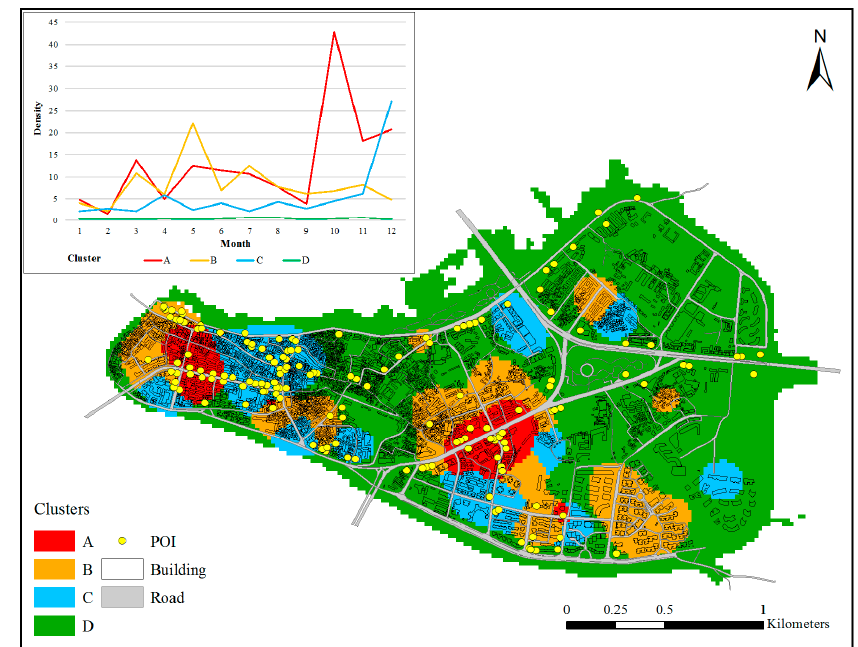
Figure 7. The four-cluster result from the STICA approach and the geography in the DP